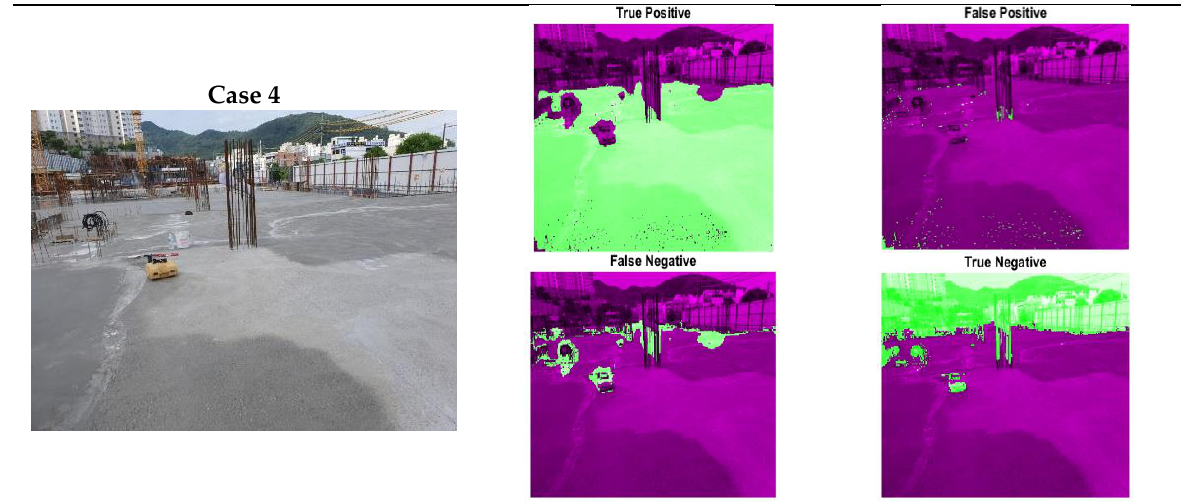
Figure 4. Examples of true positive (TP), true negative (TN), false positive (FP), and false negative (FN) from images (bright green: classified area for each selection criteria).